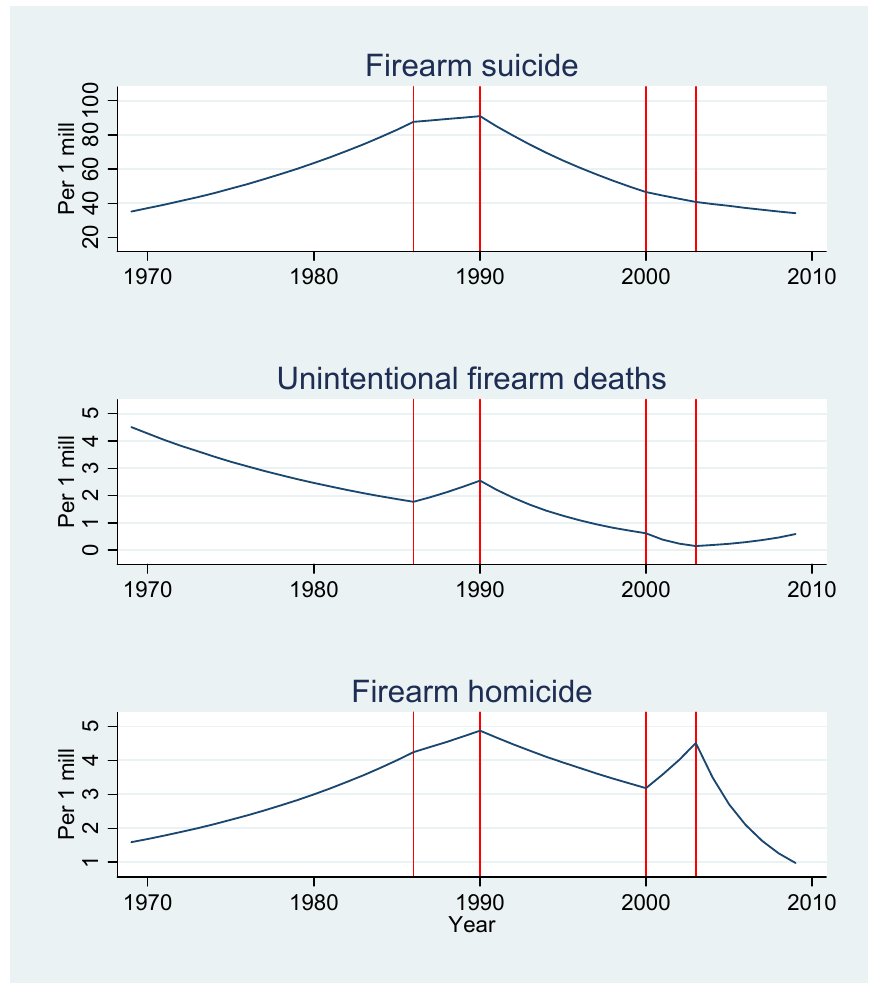
Figure 4. Estimated rates of male firearm deaths (suicide, accidents, and homicide)